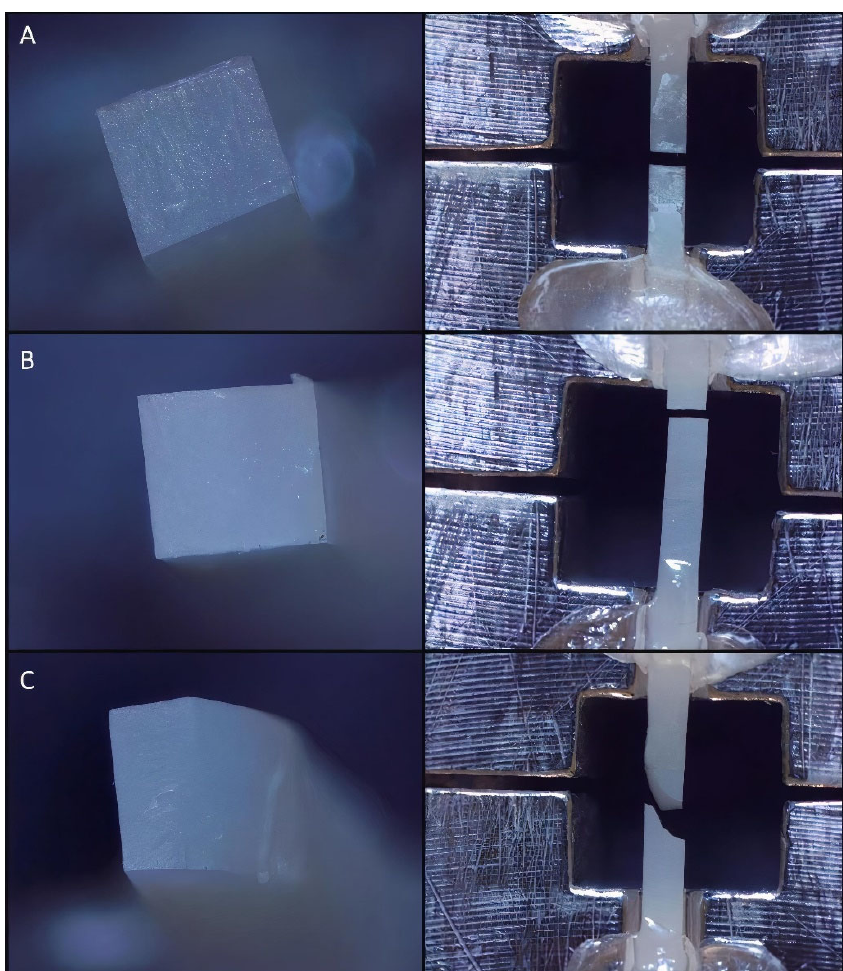
Figure 3. Different failure modes (×40 magnification). ( A ) adhesive, ( B ) cohesive, ( C )